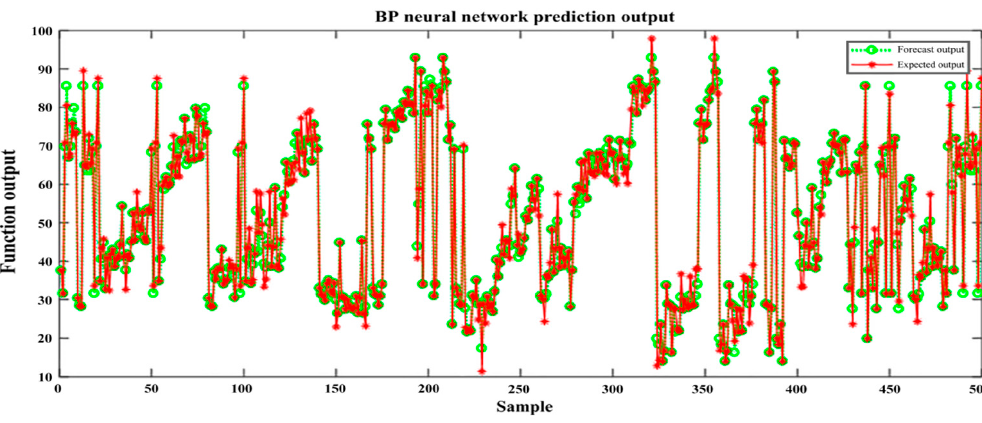
Figure 8. BP neural network simulation results.